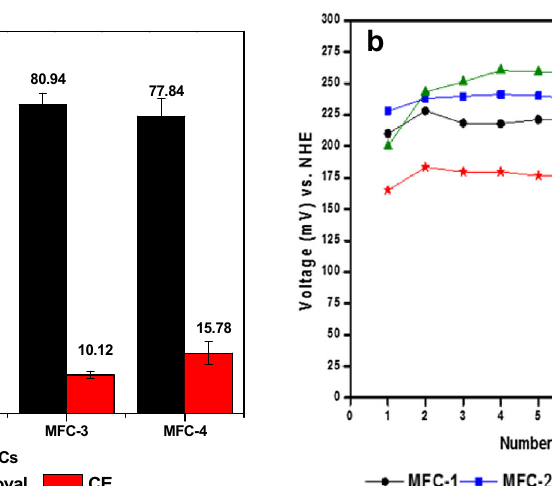
Table 2 Performance of the MFCs Parameters